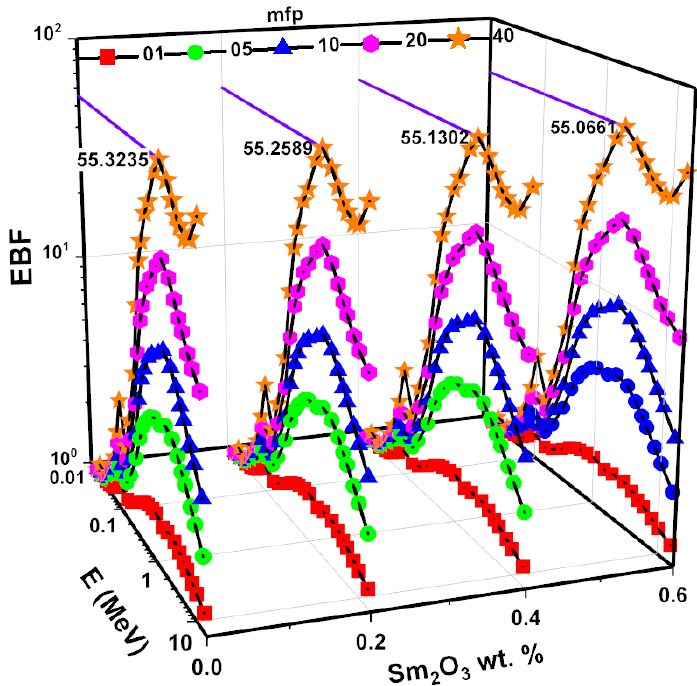
Figure 15. EBF for samples as a function of energy at 1, 5, 10, 20, and 40 mfp.